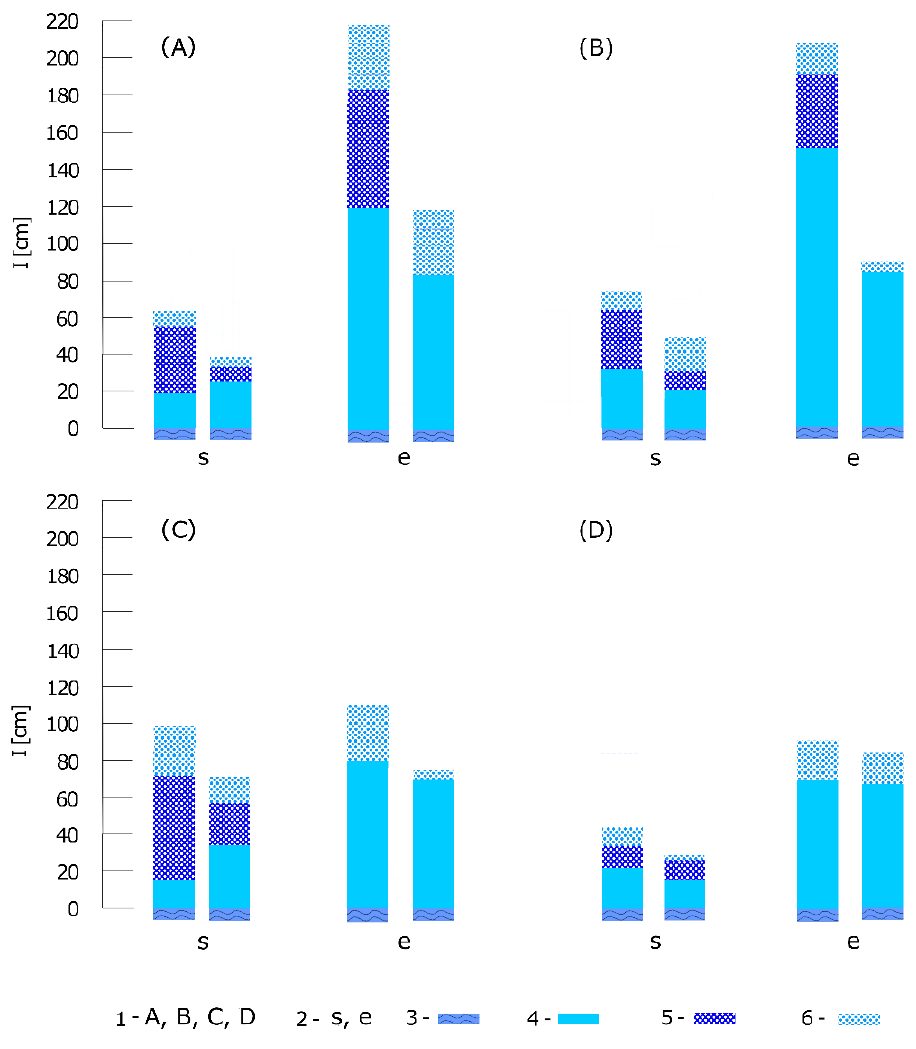
Figure 5. Ice cover structure in studied lakes in the Tatra Mountains during the 2018/2019 winter season: 1 — lakes covered by studies of ice phenomena, ( A ) Czarny Staw Gąsienicowy, ( B ) Czarny Staw pod Rysami, ( C ) Morskie Oko, and ( D ) Smreczyński Staw; 2— winter season 2018/2019 (s — beginning of the season; e — end of the season); 3 — water; 4 — ice; 5 — slush; 6 — snow; I — thickness of individual layers (cm).